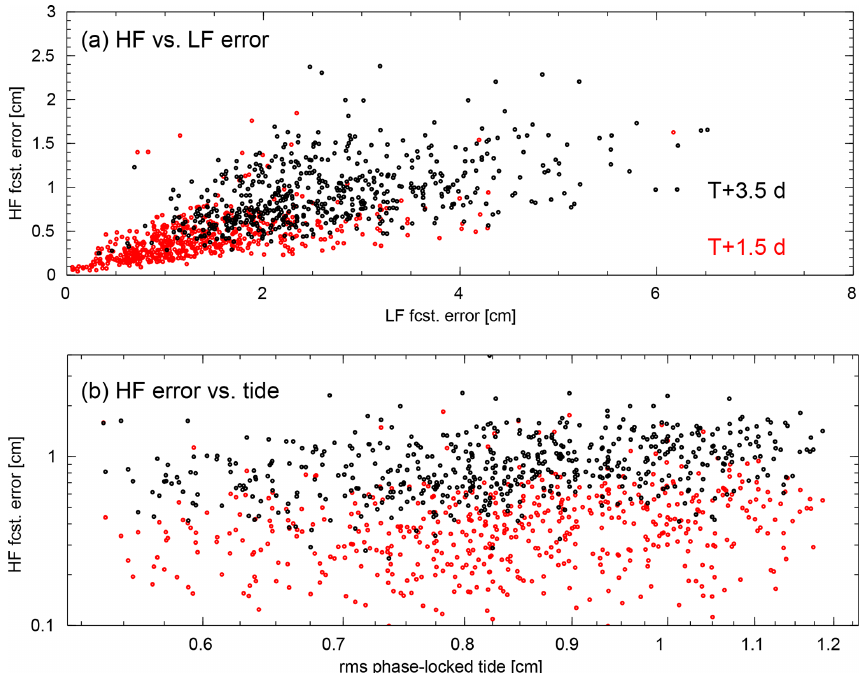
Figure 9. High-frequency (HF) forecast error. (a) HF forecast error is an increasing function of LF forecast error, and error increases as a function of lead time ( T + 1 . 5d shown in red, T + 3 . 5d shown in black). (b) HF forecast error depends weakly on the phase-locked tide (red and black dots as in panel a ).